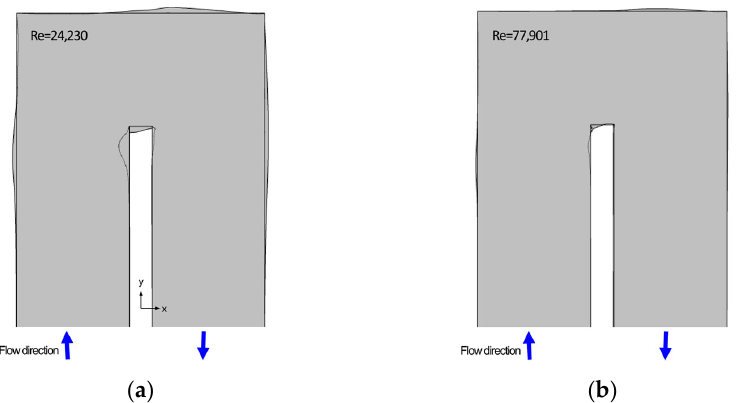
Figure 19. Geometry modi fi cation using the adjoint solver: ( a ) Re = 24,230; ( b ) Re = 77,901.